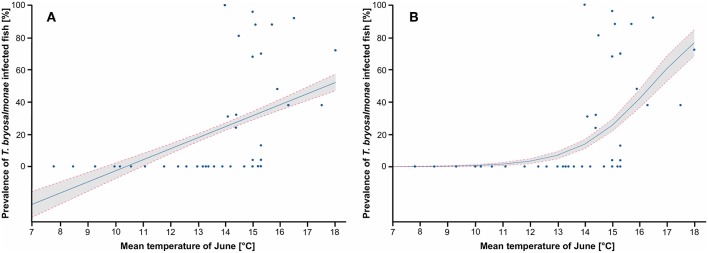
Prediction of the prevalence of T. bryosalmonae infected fish depending on the mean temperature of June. (A) Prediction of the linear probability model (LPM), R2 is 0.211. (B) Prediction of the logistic model (Logit), Pseudo R2 is 0.373. Blue points correspond to study sites, blue line corresponds to the prediction, gray zone corresponds to the 95% confidence intervals.